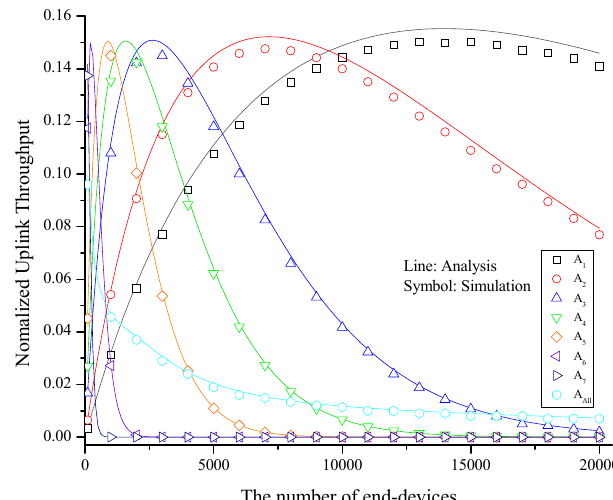
Figure 2. Normalized throughput as a function of the number of EDs.